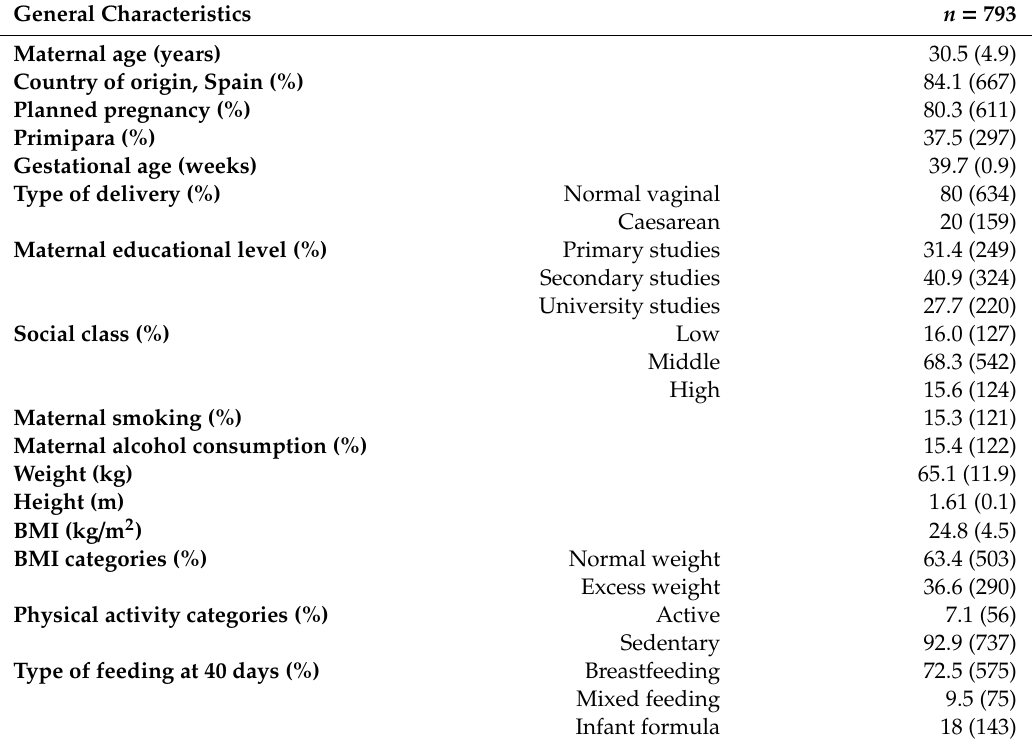
Table 1. Sociodemographic and lifestyle characteristics of pregnant women in the first trimester of pregnancy.